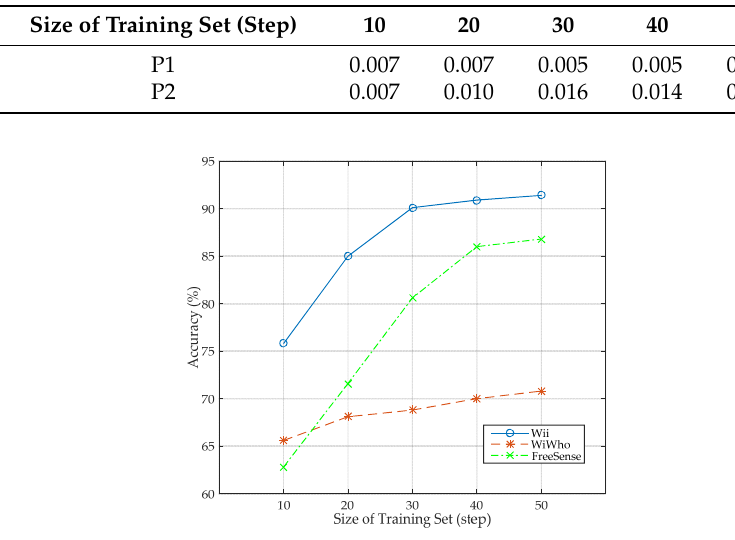
Figure 11. Kappa’s index under different sizes of training set.